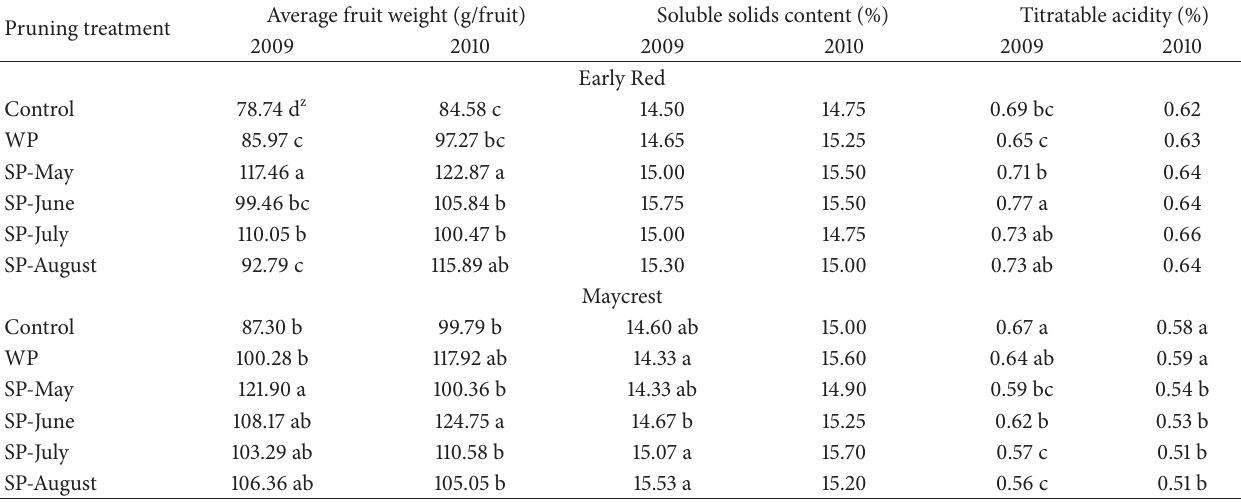
Table 3: Average fruit weight (g), soluble solids (%), and titratable acidity (%) of peaches as influenced by summer and winter pruning. Pruning treatment